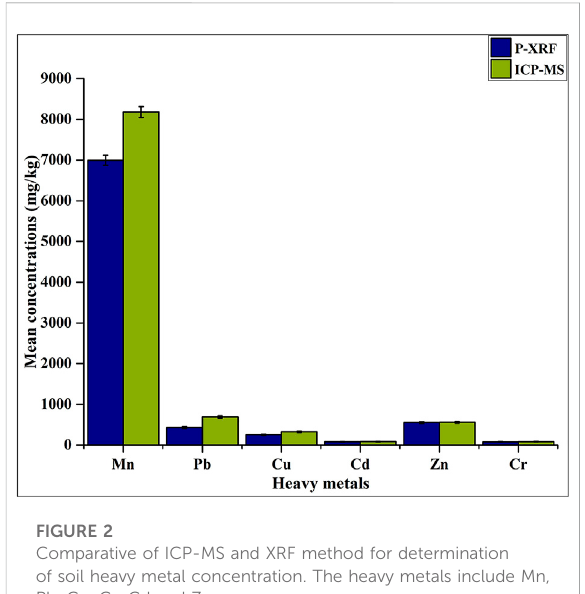
FIGURE 2 Comparative of ICP-MS and XRF method for determination of soil heavy metal concentration. The heavy metals include Mn, Pb, Cu, Cr, Cd and